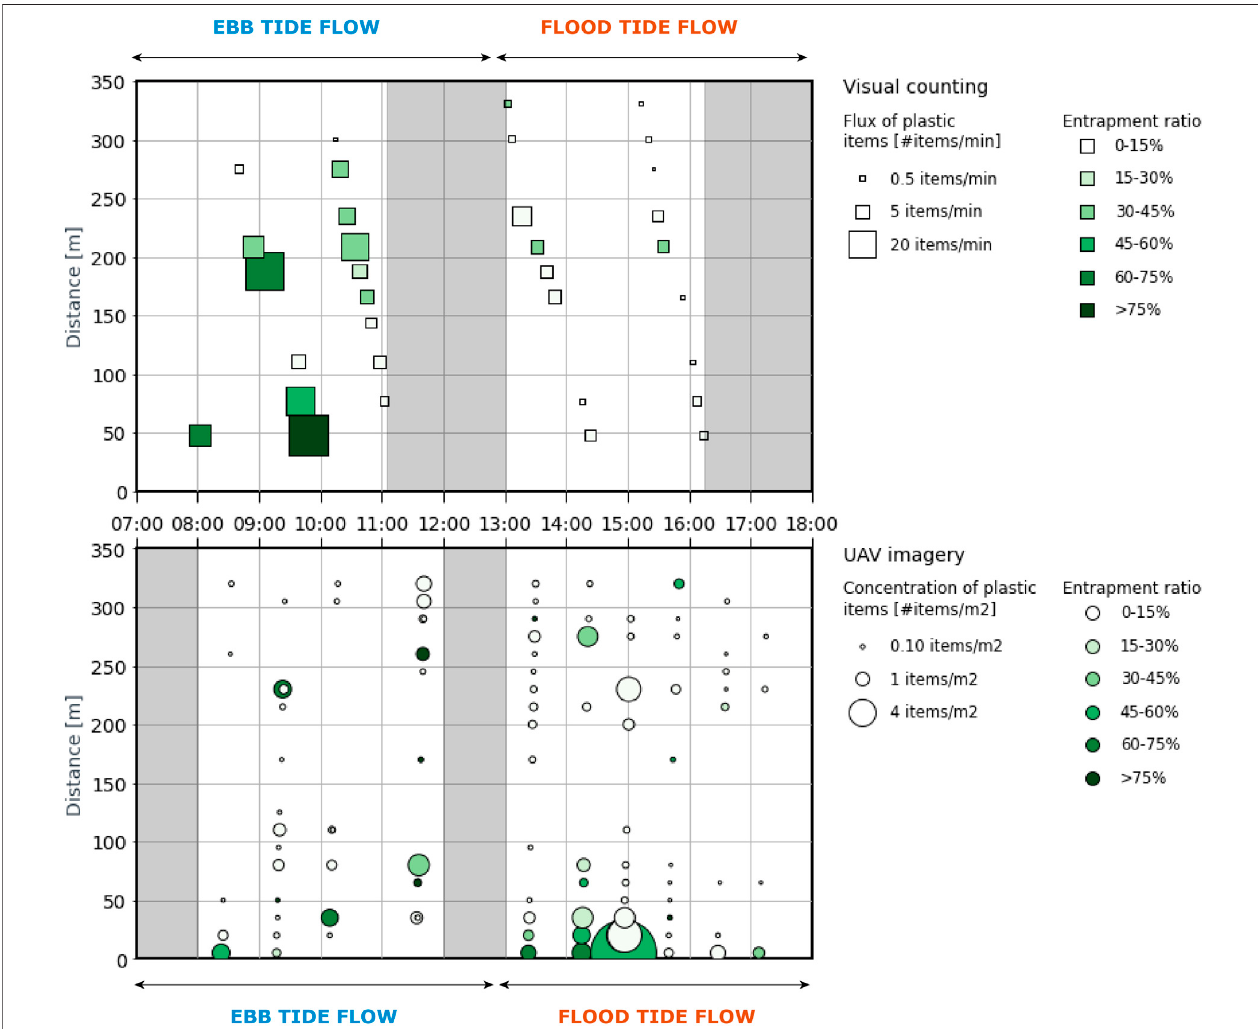
FIGURE 5 | Spatiotemporal distribution of macroplastic concentration and entrapment ratios on May 23, 2020 at Thu Thiem . Each point/square corresponds to one observation. Thegreyed areas representperiod where nomeasurementswereconducteddue tobreaks.The distance iscalculated usingthe northernriverbankas the origin. It should be noted that the fl ux of plastic items during ebb tide is seaward and landward during fl ood tide.